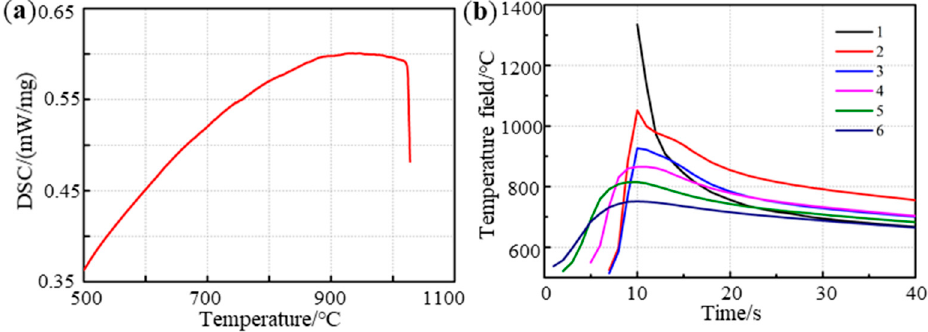
Figure 7. ( a ) DSC curve of the WAAM NAB sample, ( b ) the thermal cycle for deposited layers.